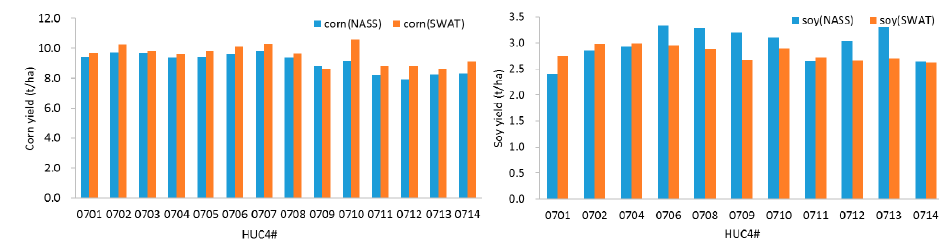
Figure 3. The mean annual corn and soybean of simulated (Soil and Water Assessment Tool (SWAT)) versus estimated (National Agricultural Statistics Service (NASS)) yield for each of the HUC4 subbasins in the UMRB.